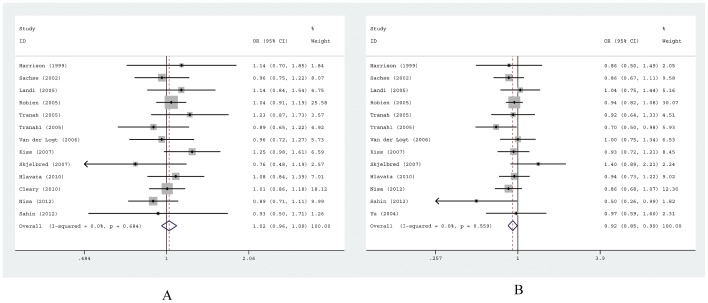
Forest plots of ORs with 95% CIs for EPHX1 polymorphisms and risk for colorectal cancer.The center of each square represents the OR, the area of the square is the number of sample and thus the weight used in the meta-analysis, and the horizontal line indicates the 95%CI. (A) Tyr113His, His/His+Tyr/His vs. Tyr/Tyr. (B) His139Arg, Arg/Arg+Arg/His vs. His/His.